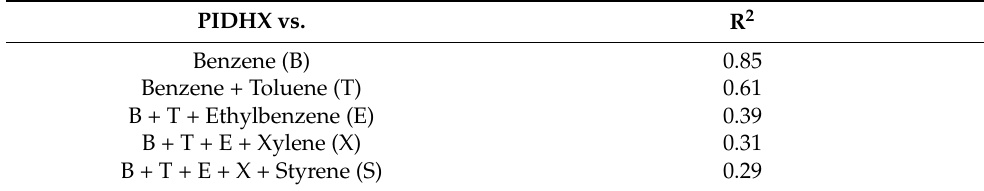
Table 9. Correlations of PID results with VOC concentrations.